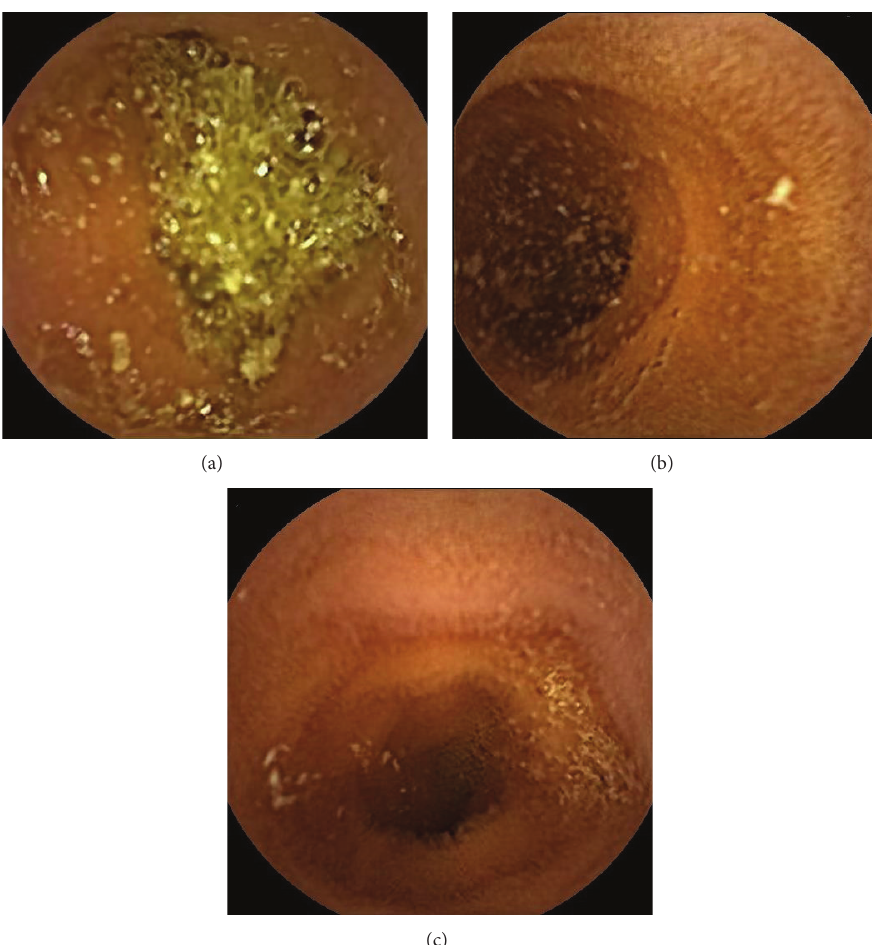
Figure 1: Typical images of each regimen. (a) P-P regimen, (b) L-P regimen, and (c) P-L regimen. (a) showed usual image. (b) and (c) showed increased amount of water in small